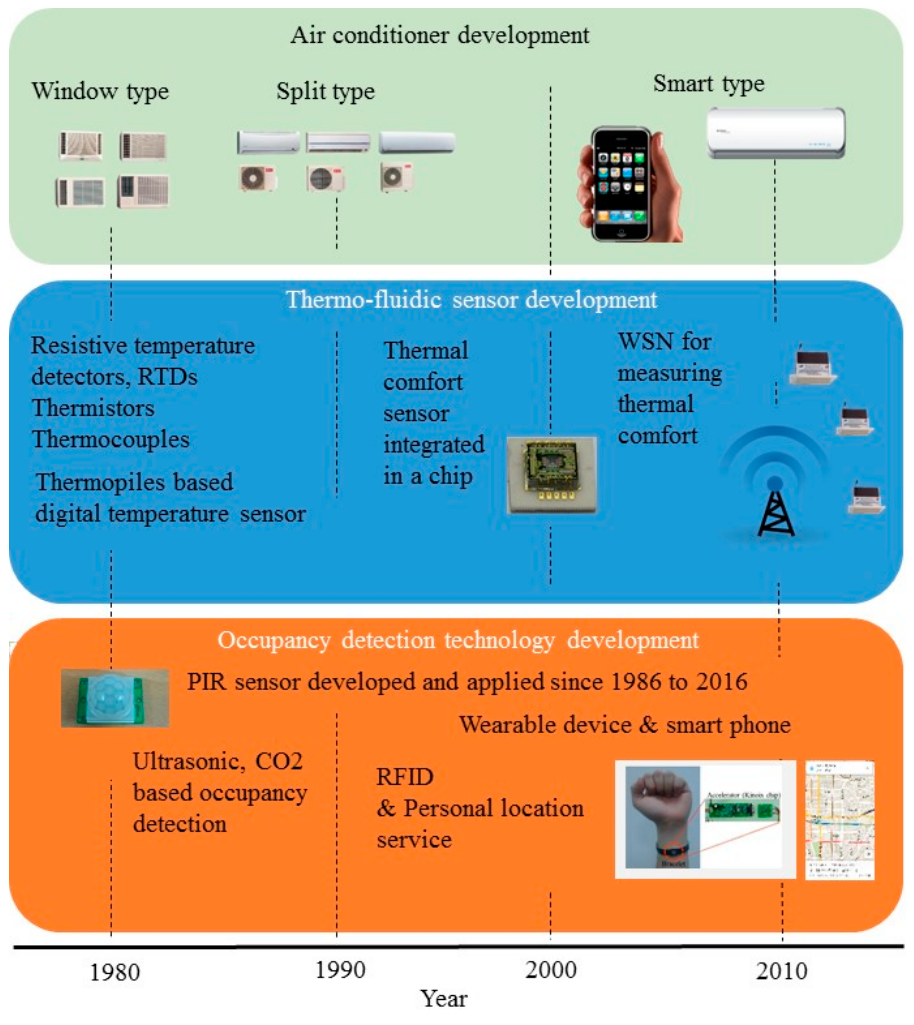
Figure 1. A brief history of the development of air conditioners, thermo-fluidic sensors and occupancy technology illustrating smart air conditioning and smart sensor development qualitatively.